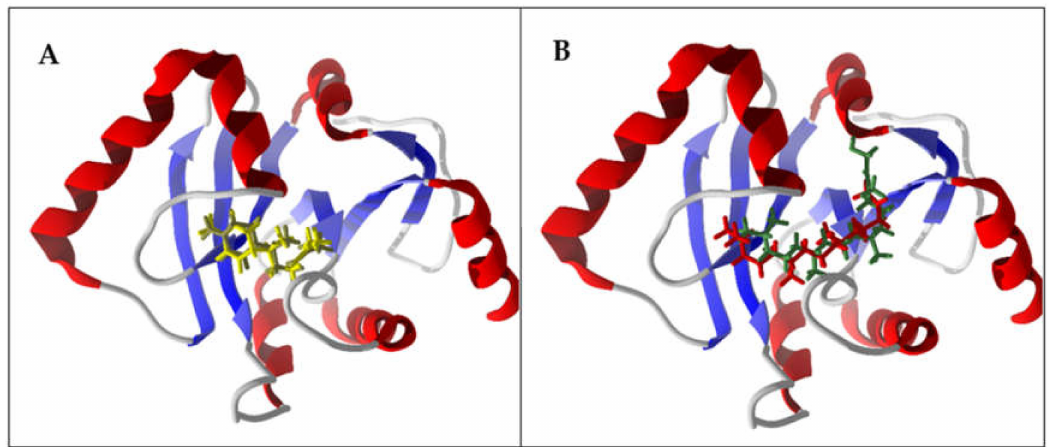
Figure 5. Lowest-energy docked poses of β -sesquiphellandrene, α -zingiberene, phytol, and phytone with SARS-CoV-2 ADP ribose phosphatase (PDB: 6W02). ( A ) Ribbon structure of the enzyme with β -sesquiphellandrene (brown) and α -zingiberene (yellow). ( B ) Ribbon structure of the enzyme with phytol (green) and phytone